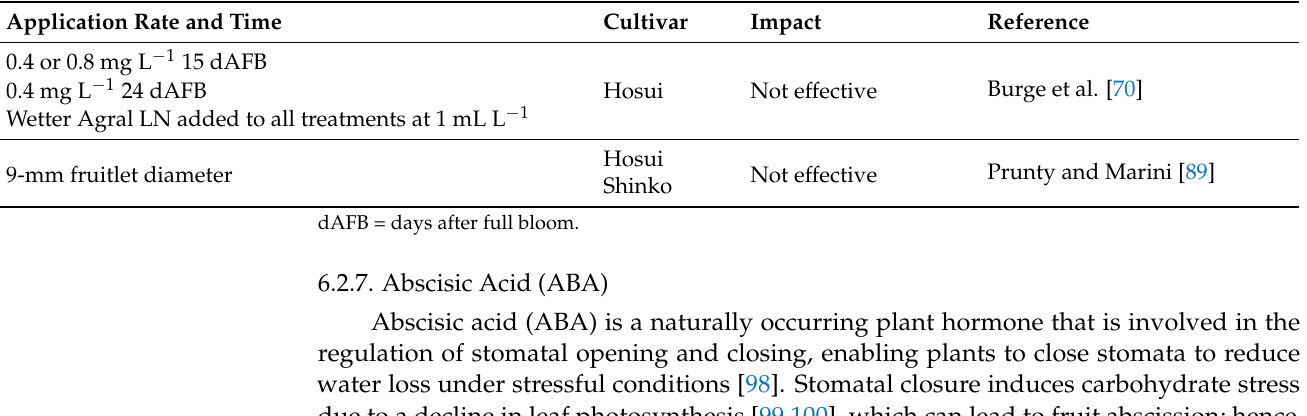
Table 12. Summary of the findings on the impact of carbaryl as a chemical thinning agent for